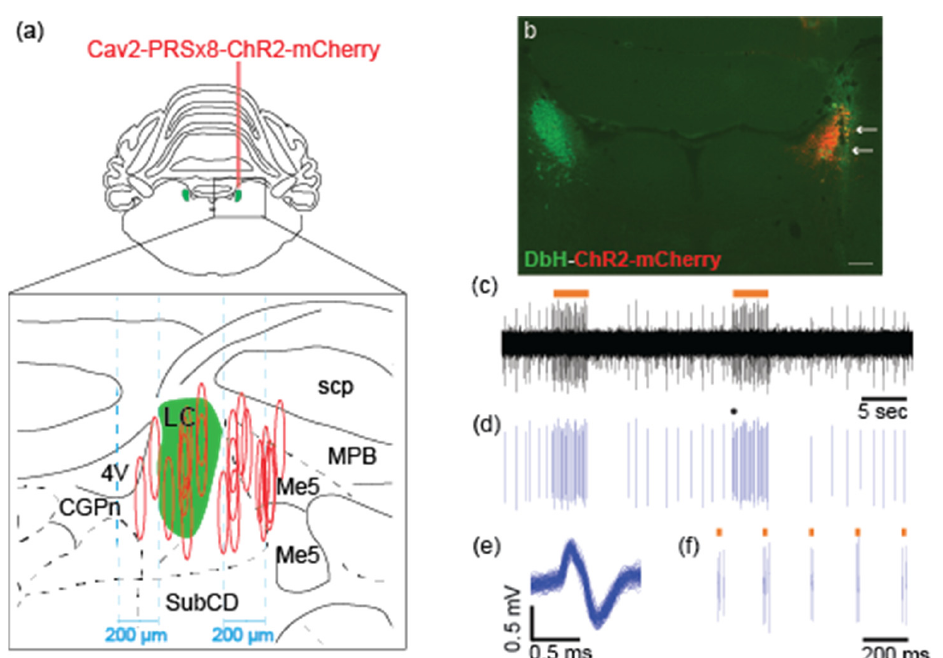
Figure 1. Histological and functional characterization of the CAV2-PRSx8-ChR2-mCherry virus transduction in the LC-NE neurons: ( a ) The LC targeting with the viral vector. Top, the coronal section from the rat brain atlas [36] containing the LC nucleus (Bregma − 9.84 m). Bottom, reconstruction of the injection sites ( n = 20). The LC core is highlighted in green. For each case, three injections were made in the dorsal-ventral plane with a total volume of 333 nl. Oval shapes represent an estimation of the virus spread; ( b ) A representative immunostained histological section corresponding to the highlighted region on (a, upper panel). The DbH staining (green) labels the LC-NE neurons. A specific expression of ChR2-mCherry (red) in LC-NE neurons is seen in the right hemisphere after 2 weeks after injection. Arrows indicate the electrode and optic fiber track. Scale bar: 200 µ m; ( c , d ) A representative segment of extracellular recording ( c ) and spike train of the LC single-unit showing spontaneous discharge and response evoked by optical stimulation (horizontal orange bar). Trains of laser pulses (30 ms, 80 mW at 5 Hz) were delivered above the LC dorsal border at a distance of ~1 mm from the recording site in the LC core. Note, stimulation-induced phasic LC activation was followed by autoinhibition; this pattern resembled the LC phasic response to a salient stimulus; ( e ) Spike waveform overlay of an isolated single unit shown on ( d ); ( f ) Expanded recording segment that is shown on ( d ). Note, that the LC single-unit discharge faithfully followed optical stimulation at 5 Hz, while spontaneous discharge was much slower; each laser pulse elicited 2 to 3 spikes.